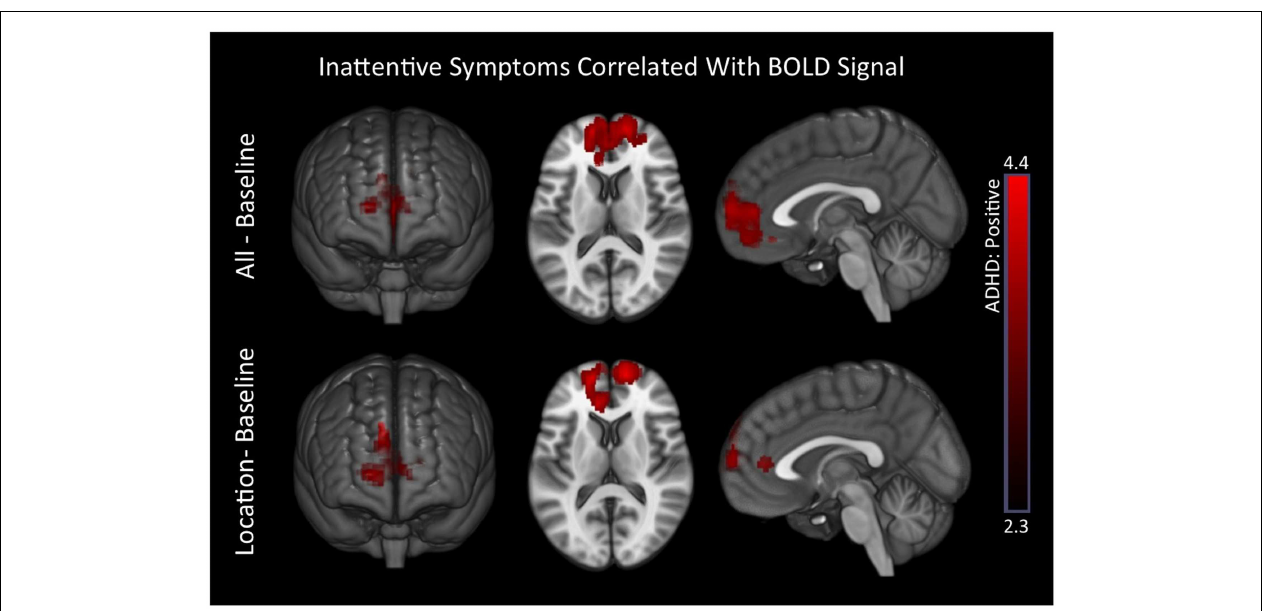
were observed in ADHD subjects for the all–baseline and location–baseline conditions. Images are thresholded using a voxelwise threshold of z = 2.3 and a cluster size probability of p <